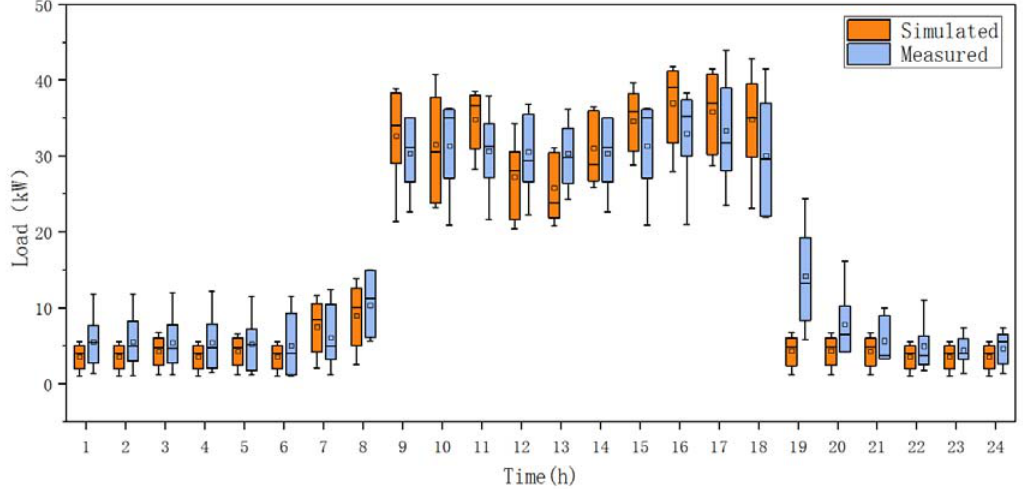
Figure 11. Comparison result of simulated value and measured value for one consecutive week. The probability density of the simulated and the measured hourly electrical load